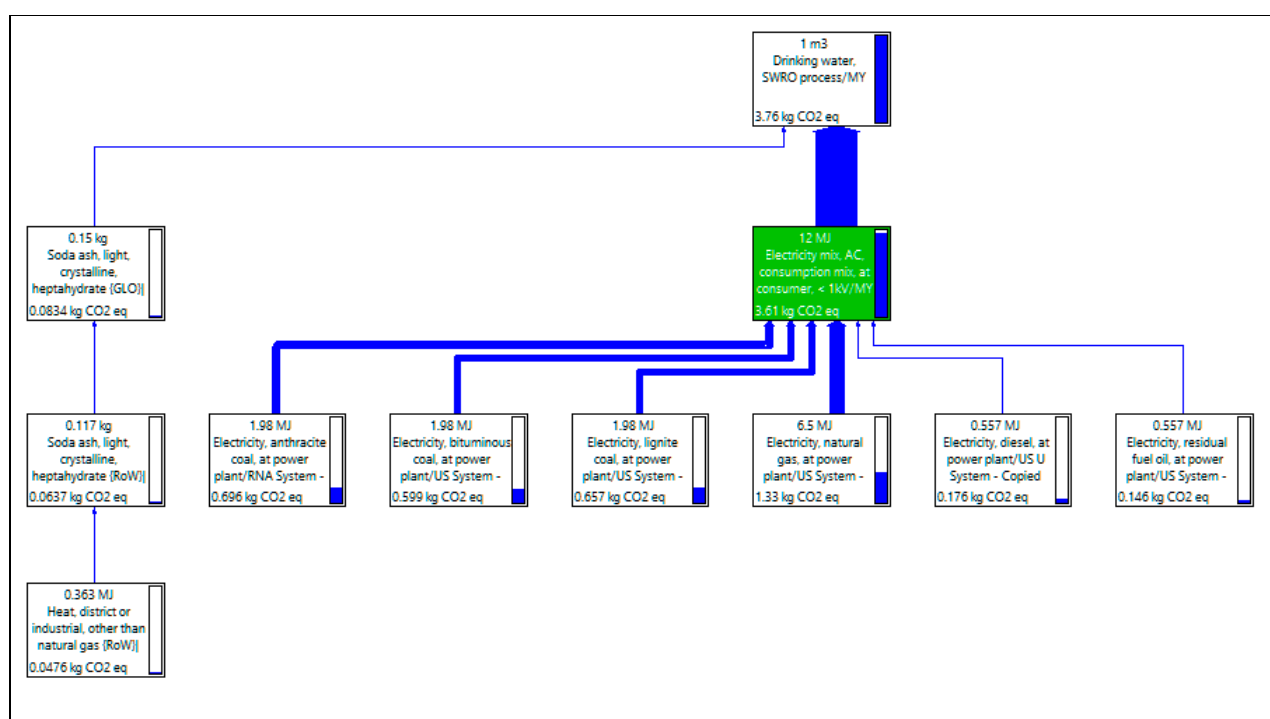
Figure 5. The results of the uncertainty analysis of this research.